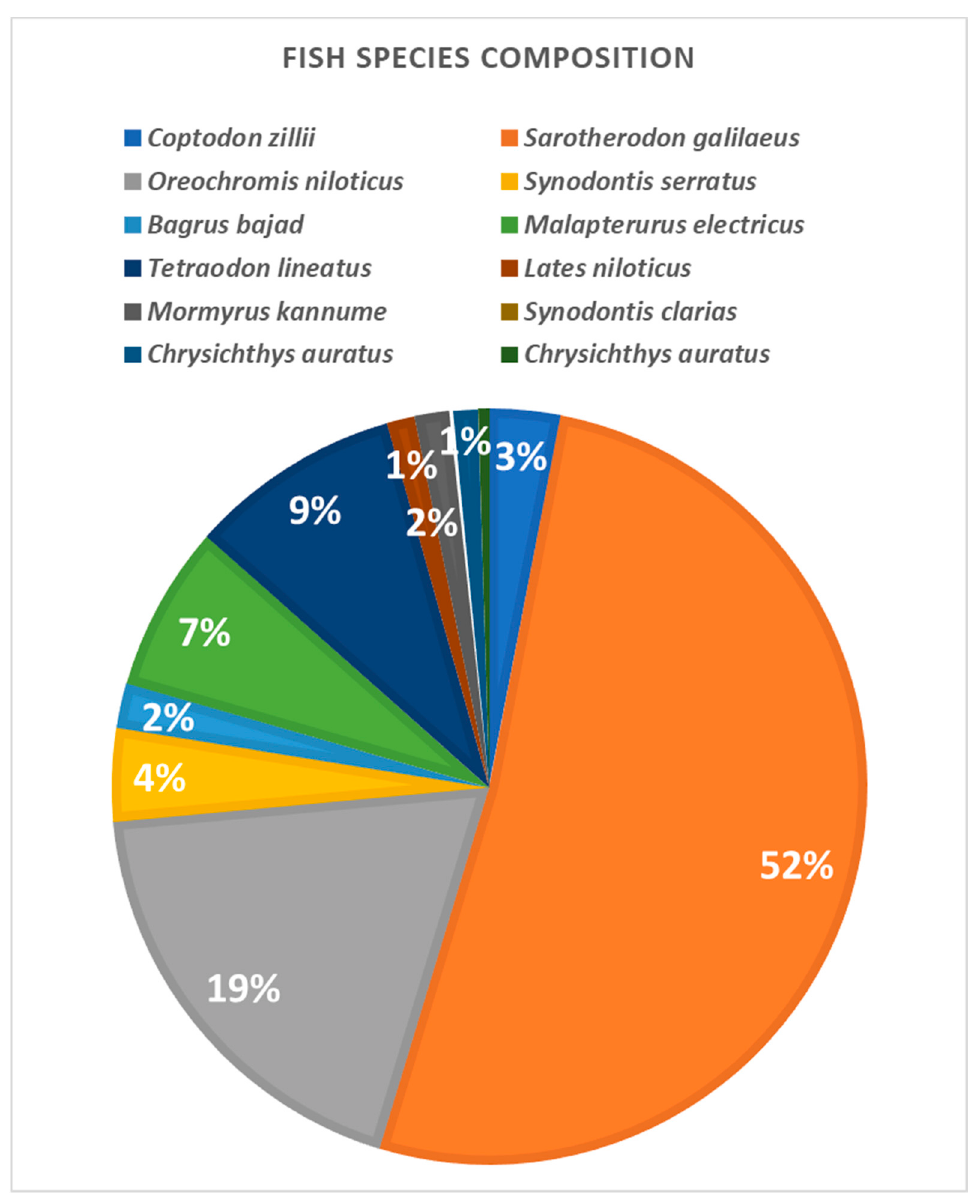
Figure 8. Species composition of the catches obtained with the trammel nets Ghazel El Shabar in Lake Nasser (percentages are by weight).